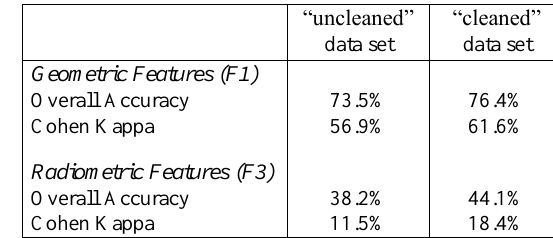
Table 3. Results of the classification (overall accuracy and Cohen